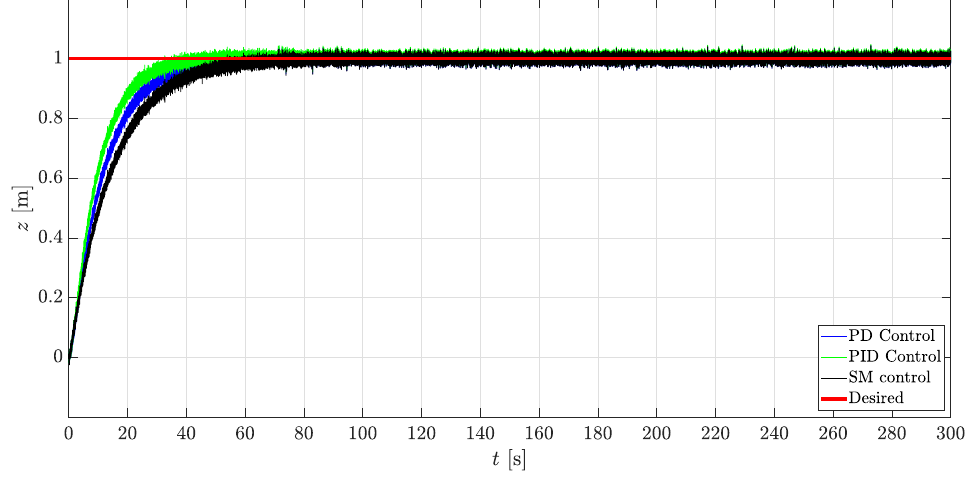
Figure 17. Translational behavior of the mini-AUV along I z